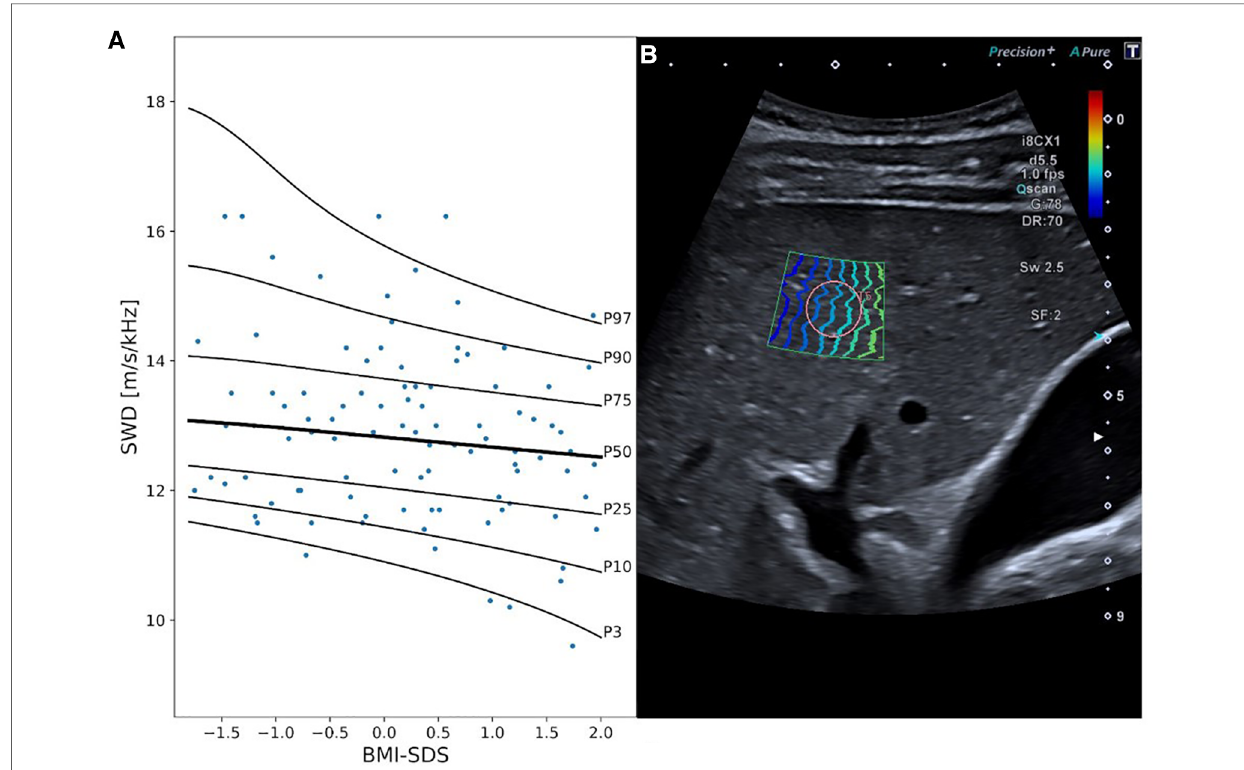
FIGURE 3 Shear wave dispersion (SWD) reference curves and exemplary 2D ultrasound SWD image. Panel A displays SWD percentile curves values in [m/s/kHz] in relationship to BMI SDS. Panel B exemplary represents an SWD measurement in a 15-year-old boy. MI, mechanical index; i8CX1, canon aplio i8CX1 transducer; d, differential tissue harmonics; fps, frames per second; Qscan, quick scan; G, gain; DR, dynamic range; Sw, shear wave frequency; SF, spatial fi